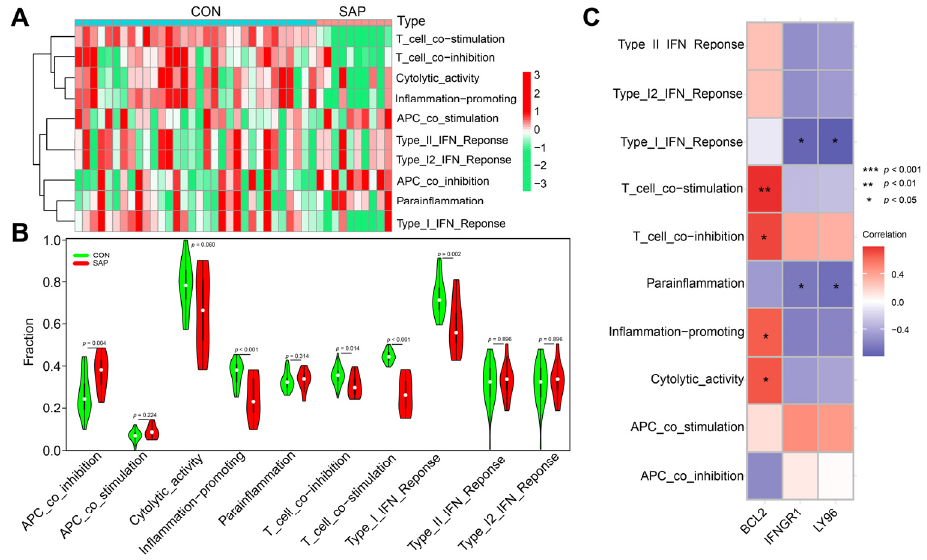
using ssGSEA. ( A ) Heat map showing the immune scores of 26 immune cells. Red indicates immune cell infiltration and blue indicates suppressed immune cells. ( B ) Violin plot showing immune scores of 26 immune cells in SAP patients and healthy controls. ( C ) Correlation between immune cell infiltration and three hub genes. * p < 0.05, ** p < 0.01, *** p < 0.001.